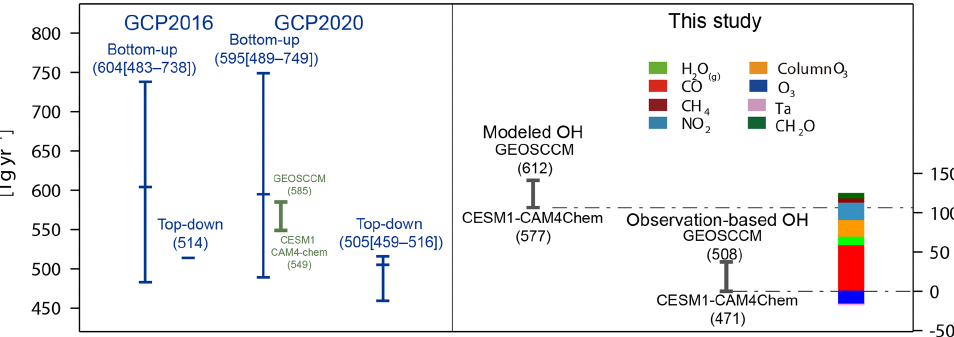
Figure 4. Global total chemical loss of CH 4 estimated by the bottom-up and top-down methods from the previous GCP global CH 4 budget (blue bars; Saunois et al., 2016, 2020), simulated by GEOSCCM and CESM1–CAM4Chem which is included in the bottom-up estimates in Saunois et al. (2020) (green bar), and that estimated in this study using the model-simulated and observation-based OH fields and CH 4 distributions assimilated surface observations (black bars). The colored bar shows the contribution of individual factors to the difference in the chemical loss of CH 4 between CESM1–CAM4Chem simulated and the corresponding observation-based OH. The blue, green, and black bars correspond to the left axis, and the colored bar corresponds to the right